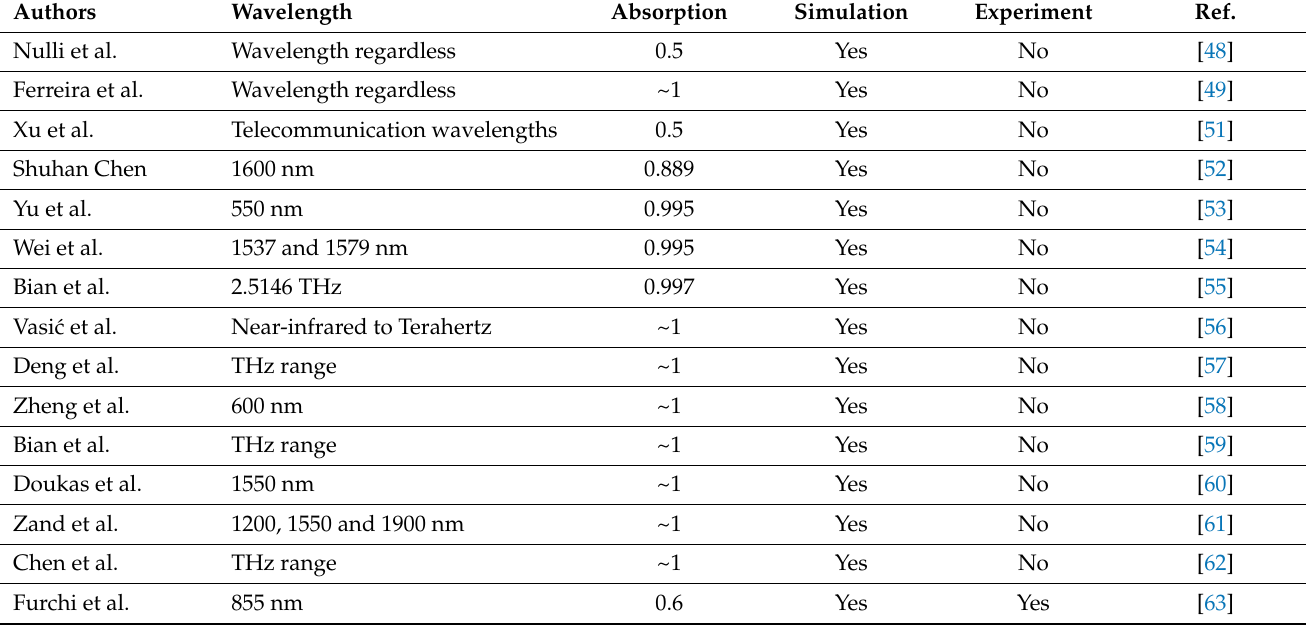
Table 1. Summary of simulated and experimental absorption of graphene inside Fabry–Perot struc- tures in the Vis-THz region, as reported in the